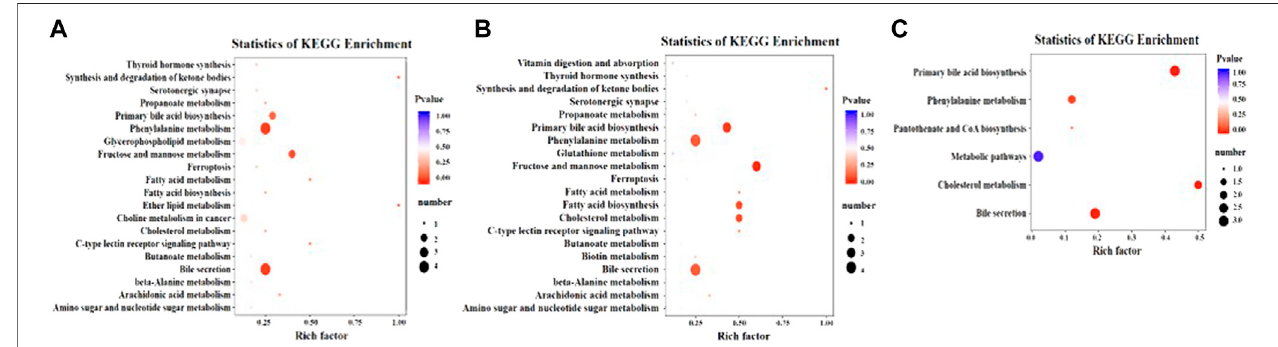
FIGURE4|(A) KEGGenrichmentdiagramofCTLandPLCcomparisongroups; (B) KEGGenrichmentofCTLandJWXYgroups; (C) KEGGenrichmentdiagramof PLCandJWXYcomparisongroups.Theabscissarepresentstherichfactorcorrespondingtoeachpathway,theordinaterepresentsthepathwayname,andthecolorof the point is the p -value. The redder the point is, the more signi fi cant the enrichment is. The size of the dot represents the number of enriched differential metabolites.